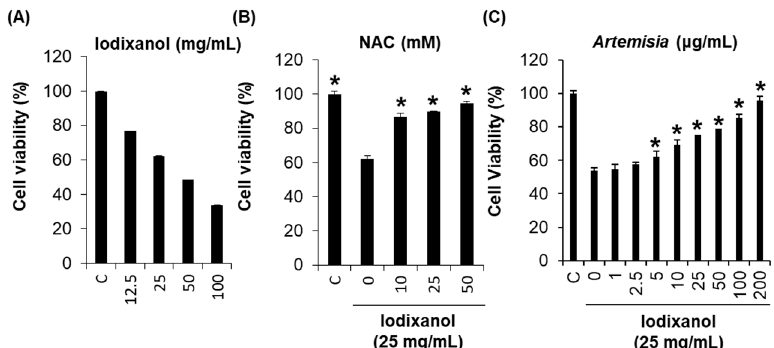
Figure 1. Structures of compounds 1 – 19 from Artemisia argyi : 3 ′ - O -methyl-eupatorin ( 1 ); artemetin ( 2 ); chrysosplenetin ( 3 ); eupatilin ( 4 ); bonanzin ( 5 ); eupafolin ( 6 ); 3,6,3 ′ -trimethoxy-5,7,4 ′ -trihydroxyflavone ( 7 ); acacetin ( 8 ); homoeriodictyol ( 9 ); jaceosidin ( 10 ); 3 ′ ,4 ′ -dimethoxyluteolin ( 11 ); 3 ′ -methoxyapigenin ( 12 ); naringenin ( 13 ); hispidulin ( 14 ); 5,7,3 ′ ,4-tetrahydroxyflavone ( 15 ); 3,4 ′ ,5,7-tetrahydroxyflavone ( 16 ); 5,7,4 ′ -trihydroxyflavone ( 17 ); 2,3-dihydroisorhamnetin ( 18 ); and apicin ( 19 ).